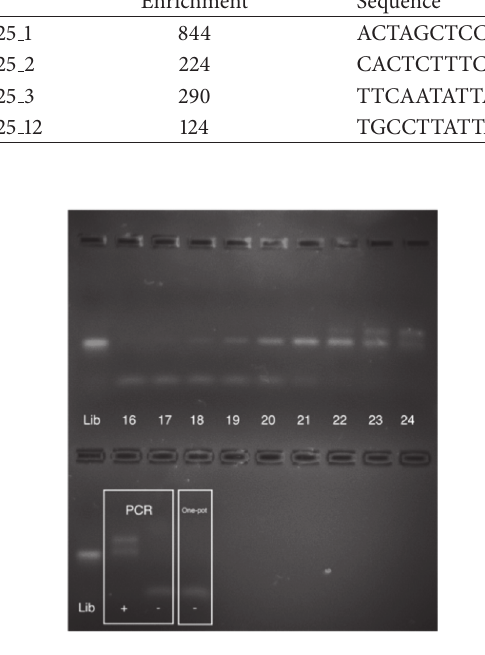
Figure 3: Representative agarose gel image showing the results of cycle determination, PCR positive and negative controls, and One- Pot negative control. The optimal number of PCR cycles is deter- mined by removing reaction tubes from the thermocycler at regular intervals and electrophoresing the reaction mixtures together on a gel. In this case, 21 PCR cycles gave desired PCR product with minimal formation of more slowly migrating byproducts. The gel image also shows that positive and negative PCR controls give the correct outcome (product and no product, respectively). Finally, the One-Pot negative control shows that tubes to which no DNA was added do not give any PCR product, as